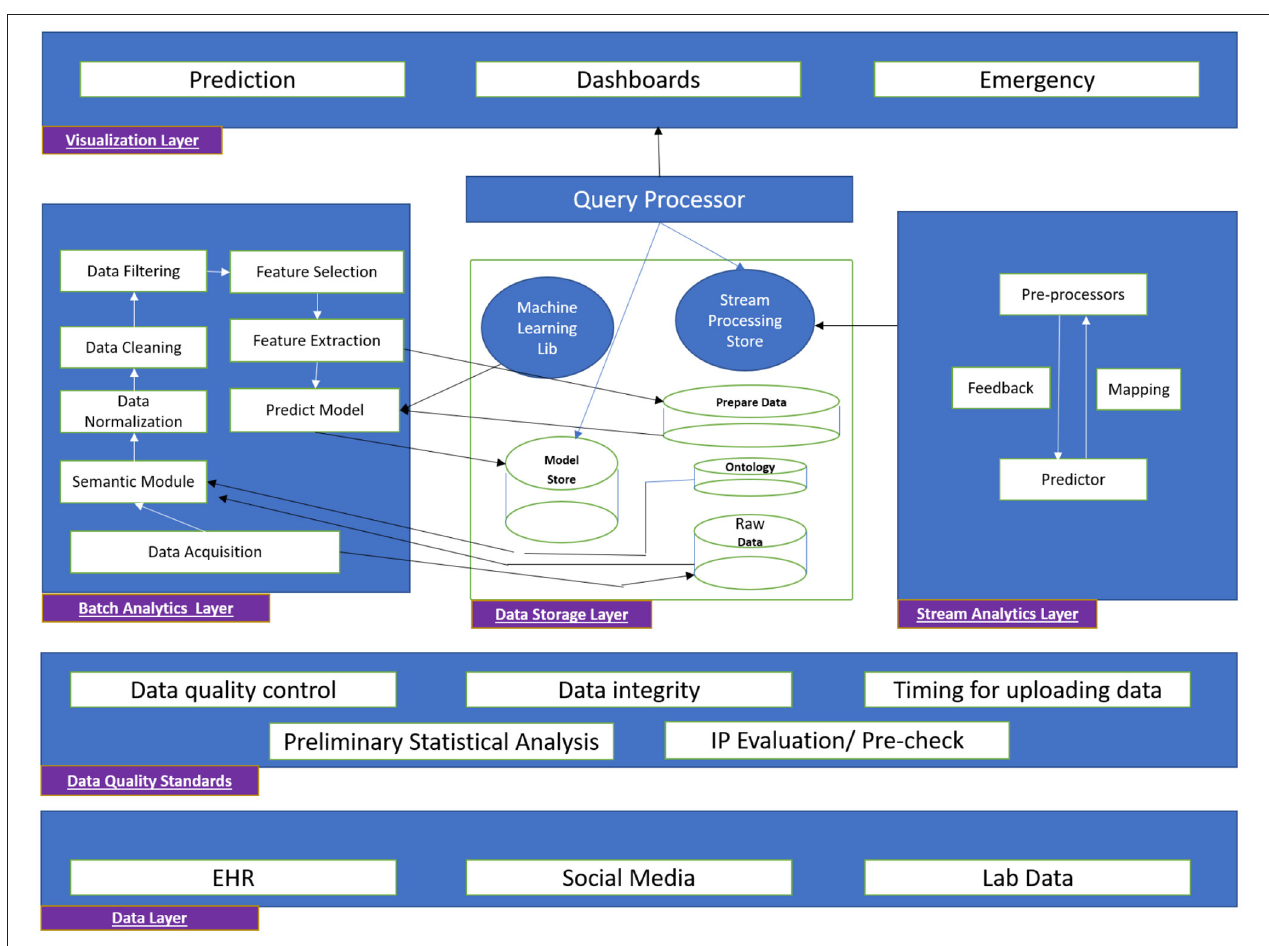
FIGURE 5 | Flow and Interaction of DMA Activities for research concept Goal 2 & Goal